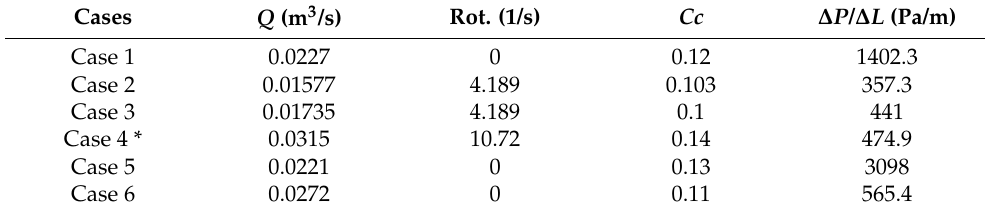
Table 4. Optimal flow rates and pipe rotation speeds, and the corresponding cuttings concentration and frictional pressure losses observed when the experimental data were analyzed for each